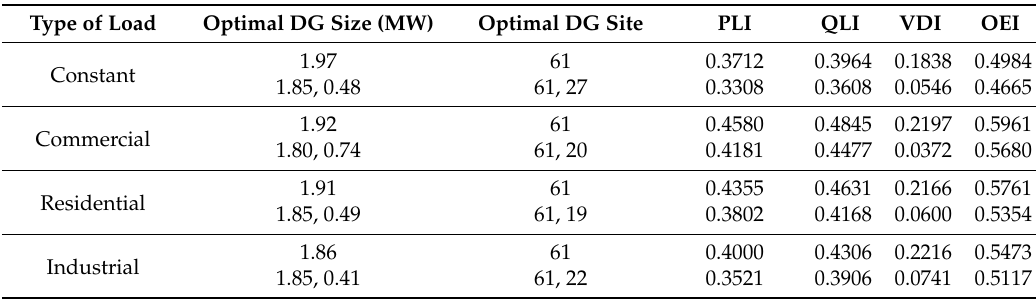
Table 8. Optimal size and site of DG for single and multiple DG placement and Indices values for multi-objective optimization (all objectives).